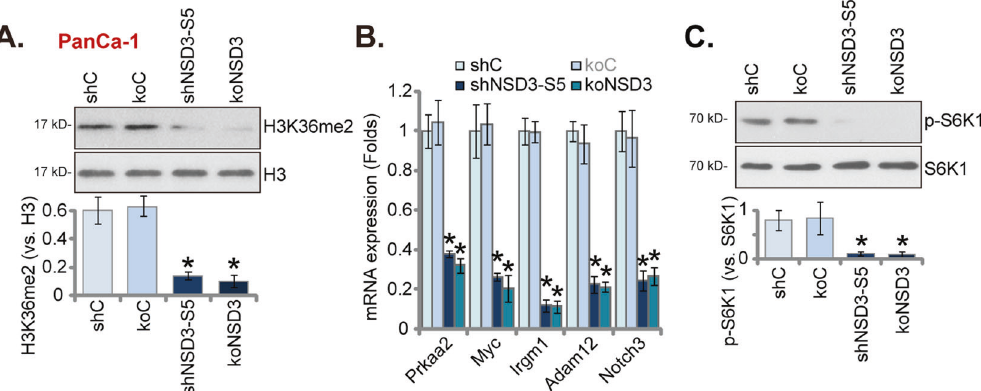
Fig. 6 NSD3 is essential for H3K36 methylation, oncogenic genes expression and mTOR activation in pancreatic cancer cells. Stable PanCa-1 cells, bearing shNSD3-S5, the scramble control shRNA ( “ shC ” ), the lenti-CRISPR/Cas9 construct encoding NSD3 sgRNA ( “ koNSD3 ” ) or the lenti-CRISPR/Cas9 empty vector ( “ koC ” ), were established and cultured; expression of listed proteins was tested by western blotting assays ( A , C ); listed mRNAs were examined by qRT-PCR assays ( B ). Data were presented as mean ± standard deviation (SD, n = 5). * P < 0.05 vs. “ shC ” cells. Experiments in this fi gure were repeated fi ve times with similar results obtained.